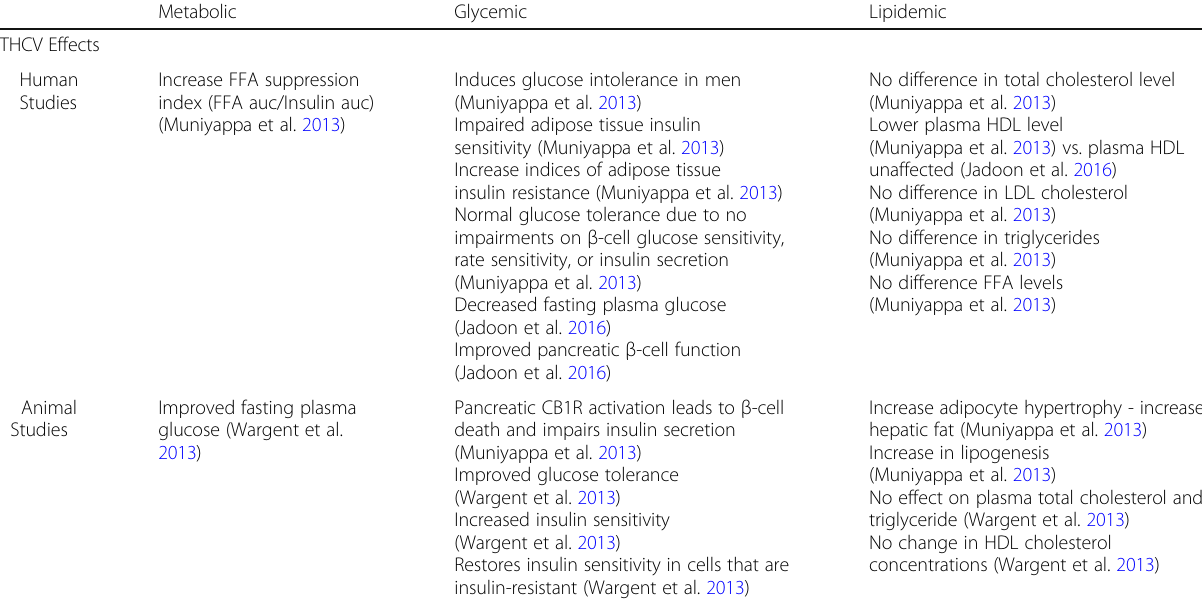
Table 1 Summarized Metabolic, Glycemic, and Lipidemic Effects of THCV